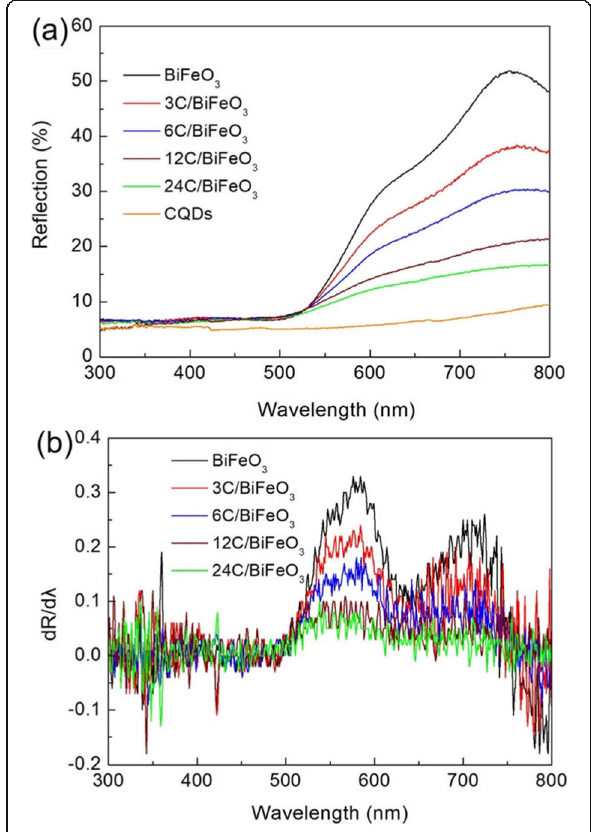
Fig. 4 a UV-vis diffuse reflectance spectra of BiFeO 3 , CQD, and CQDs/BiFeO 3 composites. b The corresponding first derivative of the diffuse reflectance